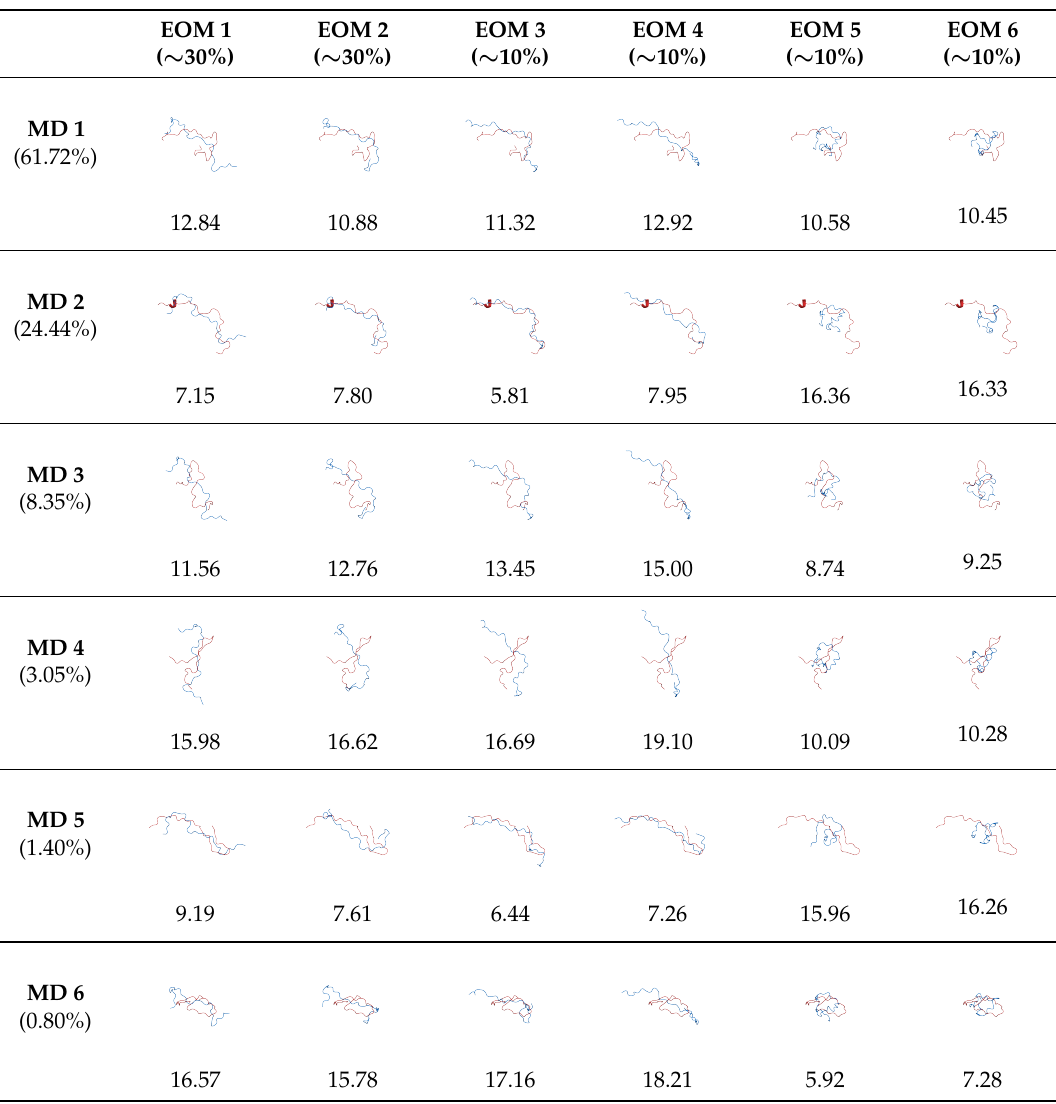
Table 4. Comparisons between representative structures from cluster analysis of MD simulations (red) and structures obtained from EOM analysis of experiment SAXS data (blue). The percentage of all structures that belonged to each cluster is given in the parentheses; MD clusters summed up to 99.75%, and EOM structures summed up to ∼ 100%. RMSD values (Å) of aligned atoms given below each